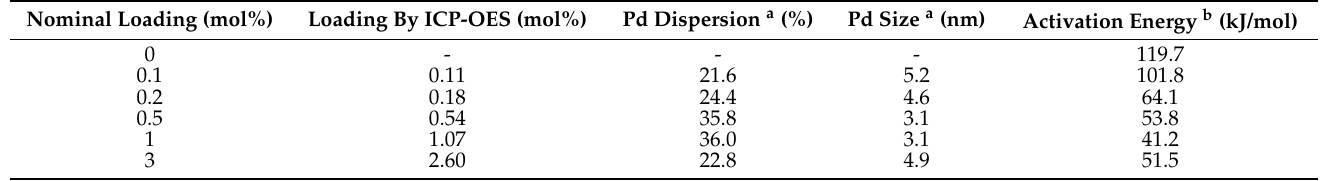
Table 1. Palladium loading, dispersion, cluster size, and activation